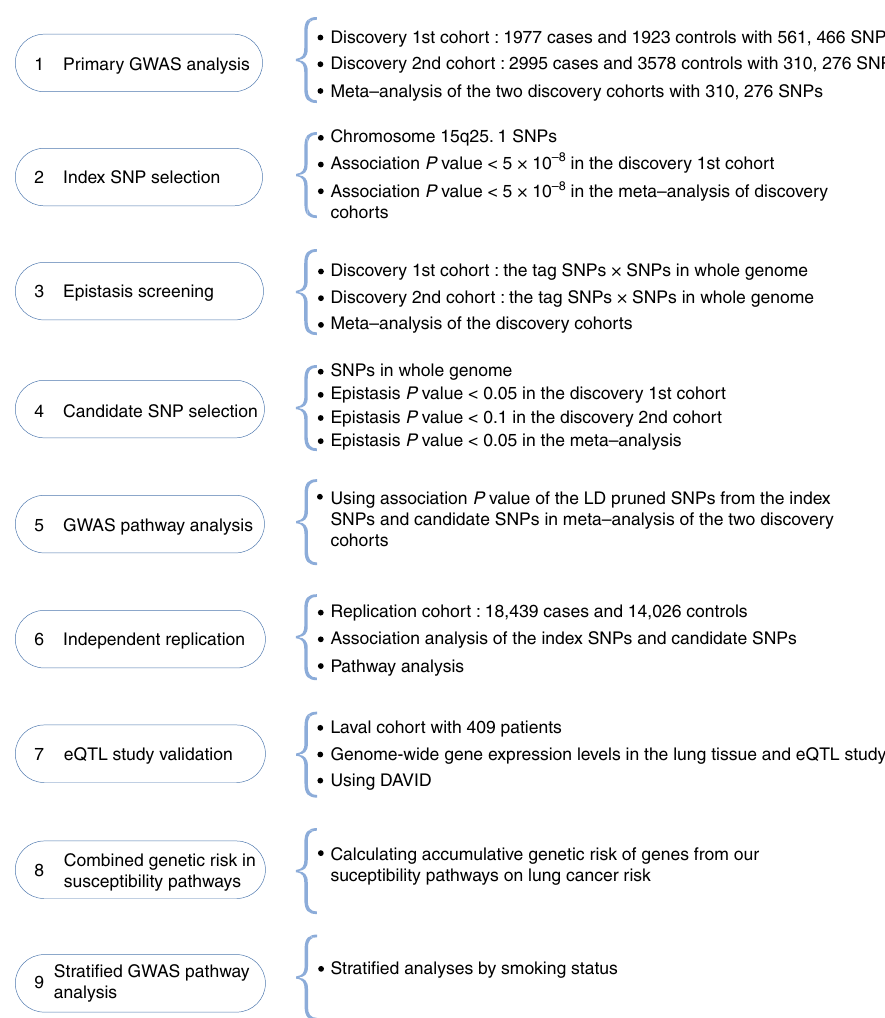
Fig. 1 Schematic overview of the study design. (1) In the discovery phase, a total of 310,276 SNPs were the same in both the 1st and 2nd discovery cohorts and were applied for association analyses and meta-analyses. (2) SNPs within the 15q25.1 locus, which were associated with lung cancer risk with logistic regression P values of less than 5 × 10 − 8 in the 1st discovery cohort and in the meta-analysis of the discovery cohorts, were selected as index SNPs. (3) The epistasis test between SNPs in the whole genome and the index SNPs within chromosome 15q25.1 locus were conducted for both discovery cohorts and a meta-analysis was performed to combine the epistasis results. (4) The SNPs, which interacted with the index SNPs with an epistasis P value of less than 0.05 in the 1st discovery cohort and in the meta-analysis of both discovery cohorts, and less than 0.10 in the 2nd discovery cohort, were selected as the candidate SNPs. (5) The index SNPs and the candidate SNPs with the logistic regression P values in the meta-analysis of discovery cohorts were applied for GWAS pathway analysis. (6) In the replication phase, the index SNPs and the candidate SNPs with the logistic regression P values in an independent cohort were applied for GWAS pathway analysis to validate the susceptibility pathway enriched in step 5 . (7) The most signi fi cant genes in the whole genome regulated by SNPs in chromosome 15q25.1, which were selected with the eQTL study, were employed for pathway analysis. (8) The individual and combined effects of genes in the pathways on lung cancer risk were calculated. (9) A similar process to select index SNPs and candidate SNPs and to carry out GWAS pathway analyses in the subgroups of smokers and non-smokers were